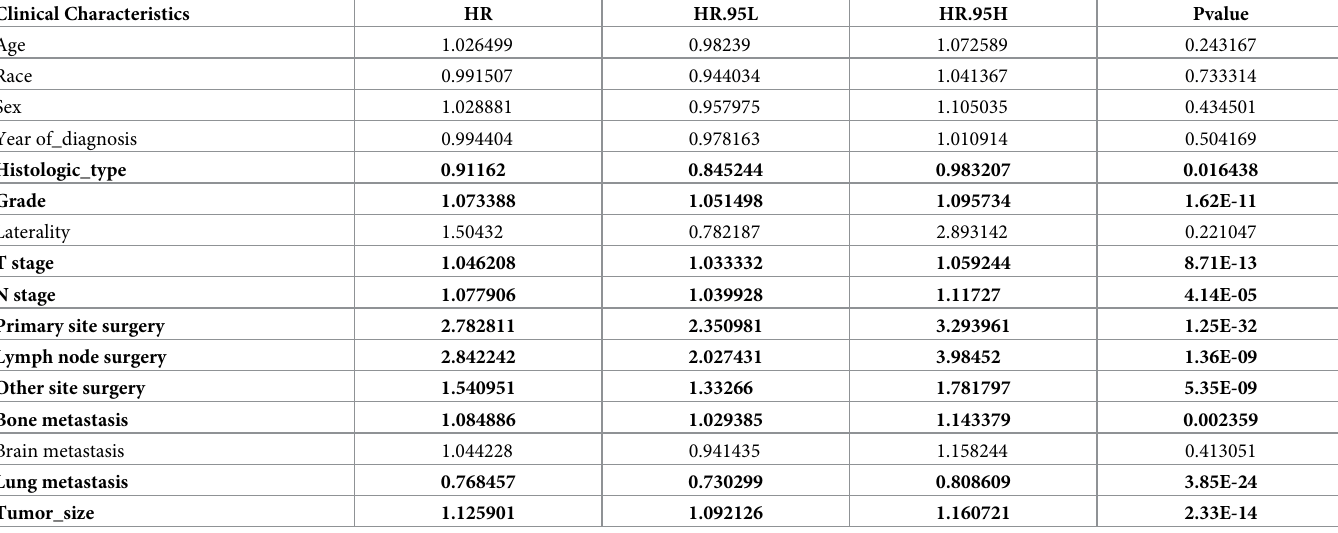
Table 4. Univariate-Cox regression analysis of the cohort